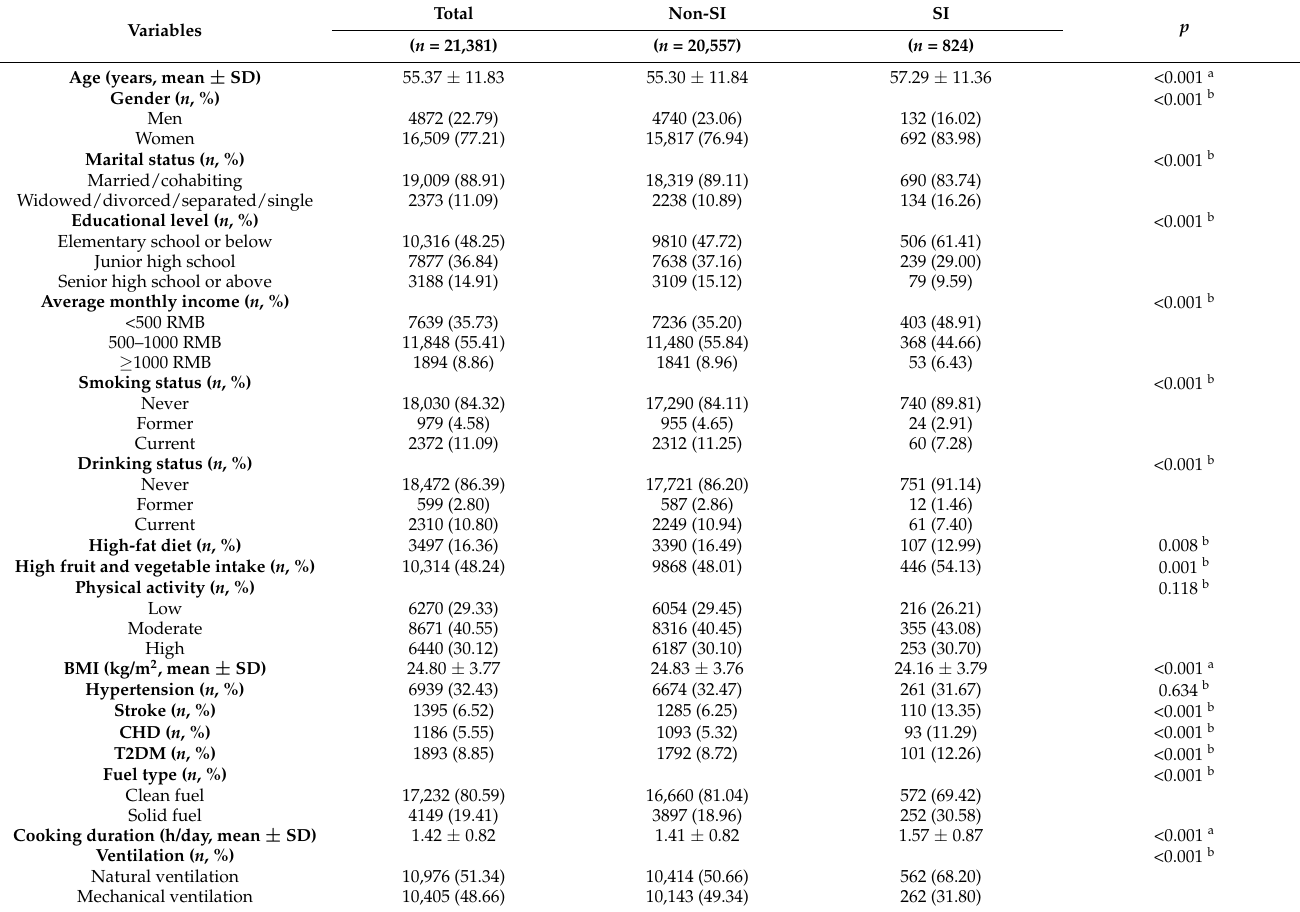
Table 1. Basic characteristics of study participants according to suicidal ideation ( n =